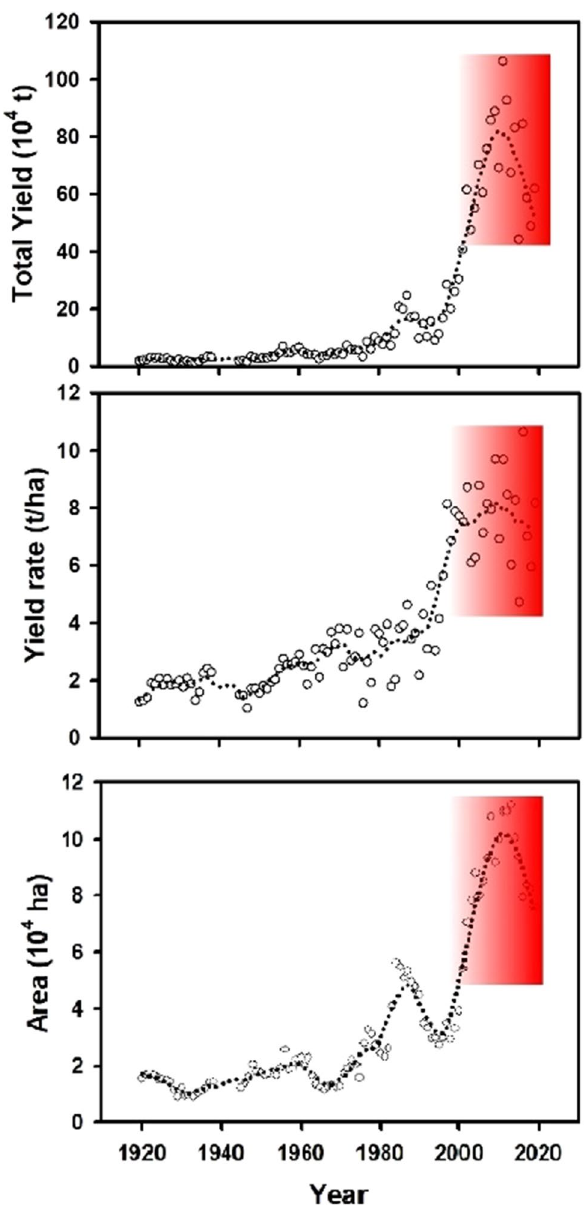
Figure 2. Grain maize total yield and yield rate in the Czech Republic during 1920–2019. The dotted curve is polynomial regression and weights computed from the Gaussian density function. The red area highlights the change in year